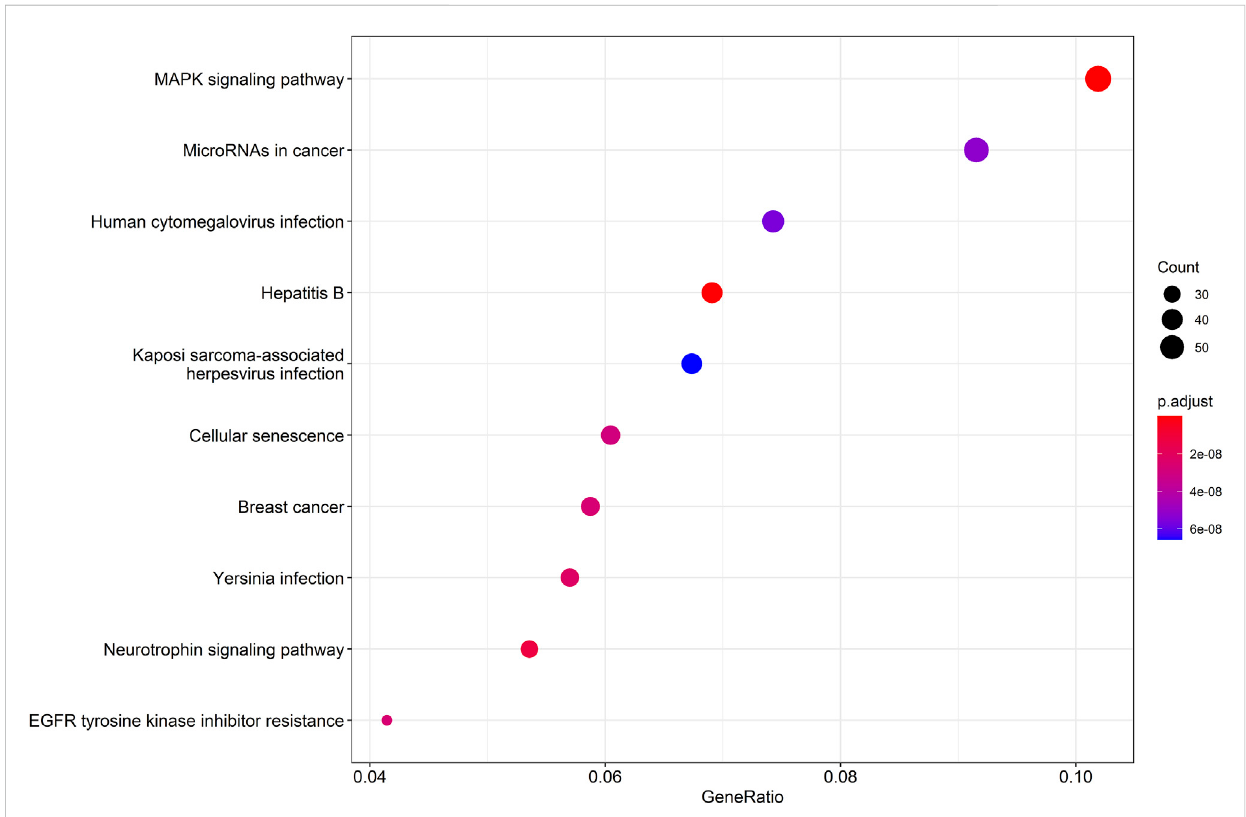
FIGURE 4 KEGGpathway enrichmentanalysis diagram. KEGGpathway enrichmentanalysisoftarget genes( p < 0.05 and q < 0.05),KEGG:KyotoEncyclopedia of Genes and